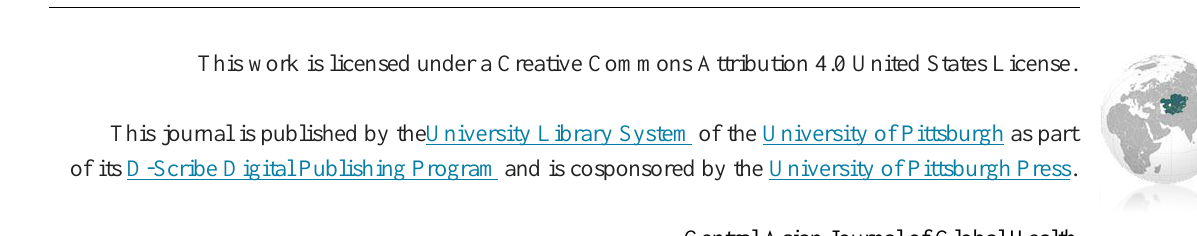
Table 2 . Sample characteristics by diabetes types, duration, and diagnosis associated